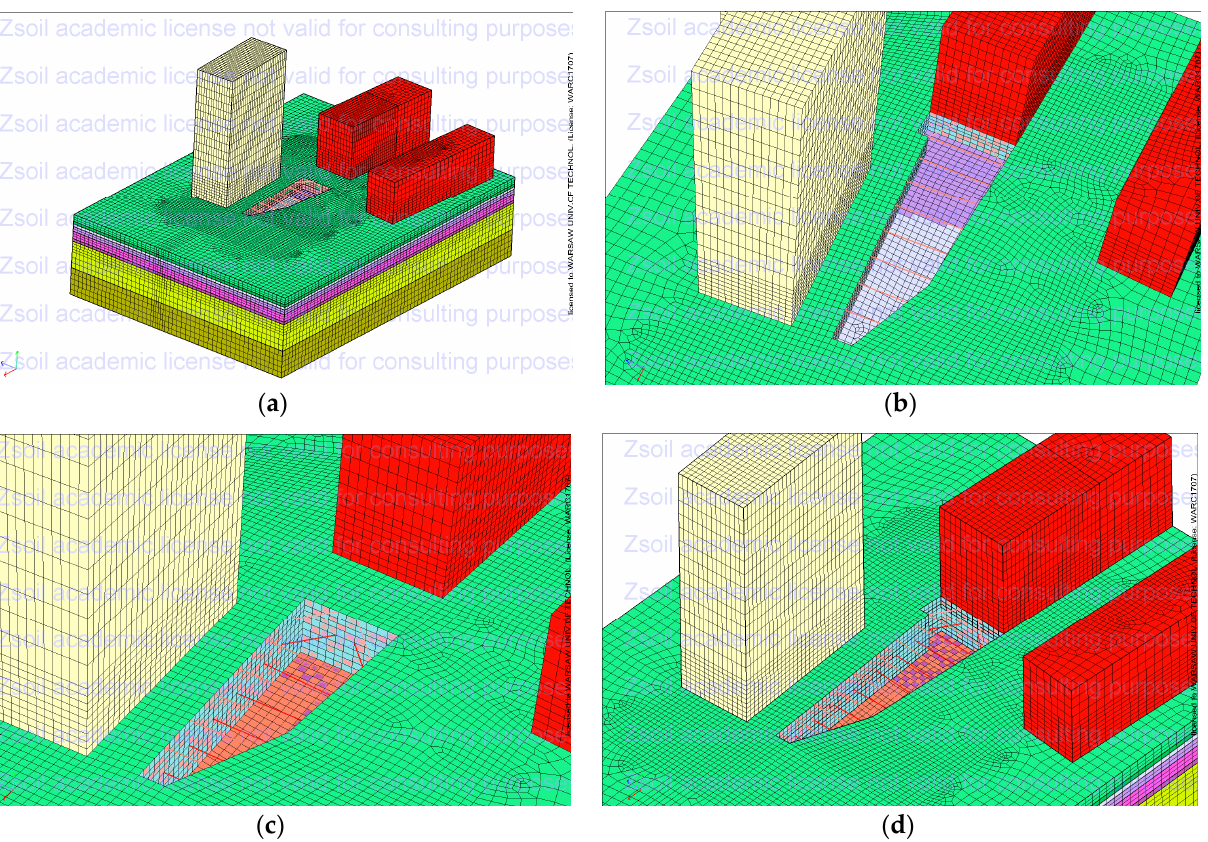
Figure 8. Three-dimensional numerical model of the building at 1A Ludna Street with the adjacent buildings and subsoil made using the ZSoil 2016 program: variant A ( a ), variant B ( b ), variant C ( c ), variant D ( d